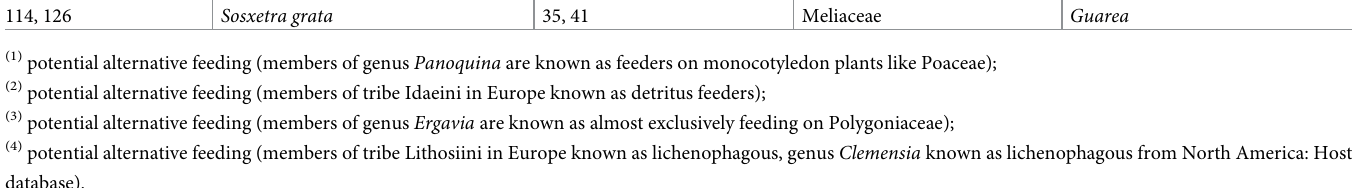
S1 Table. Morphology-based identification of target trees. Morphology-based identification of target trees to Peruvian vernacular names (mostly provided by the administrator of the Pan- guana station, Moro Carlos Va´squez Modena) and attempt to assign scientific family / genus / or species names (partly provided by Hamilton Paredes (“HP”), Museum of Natural History, Lima, based on leaf samples). # = fogging sample from target tree without lepidopteran larva; � = no plant tissue available, so far (hence no molecular confirmation possible): 1 = same vernac- ular name with two different molecular identifications. S2 Table. Target trees: Sequencing success and process identification numbers. Data from BOLD, with fragment lengths in basepairs (bp). Sanger sequencing of rbcL, trnL-F and psbA genes, based on leaf (l) and cambium+sapwood (c) samples from the target trees.